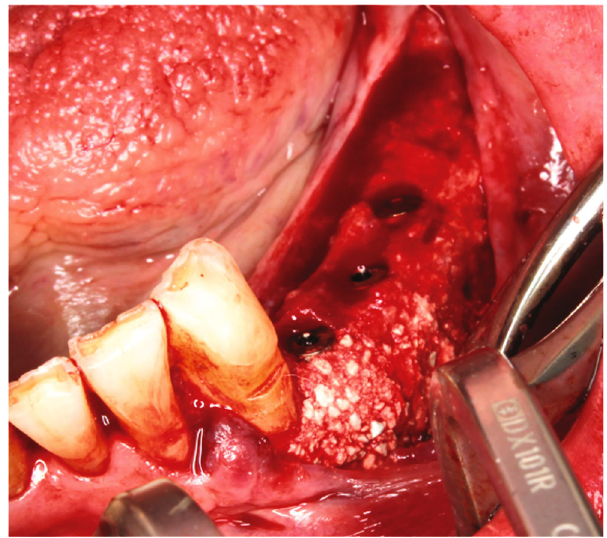
Figure 24: Tapered Screw Vent TSVT MTX Zimmer Biomet ™ implants inserted in region 34, 35, and 36.